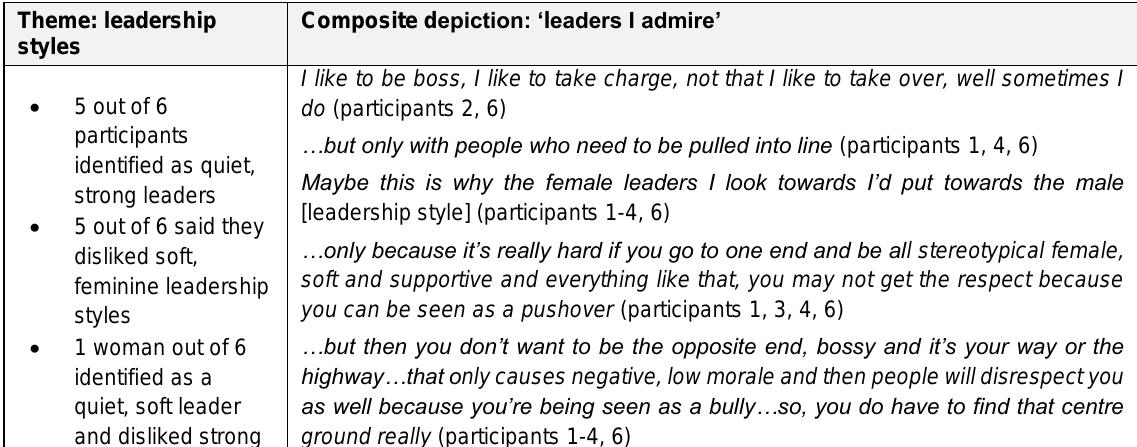
Composite depiction: division around campaigning for gender